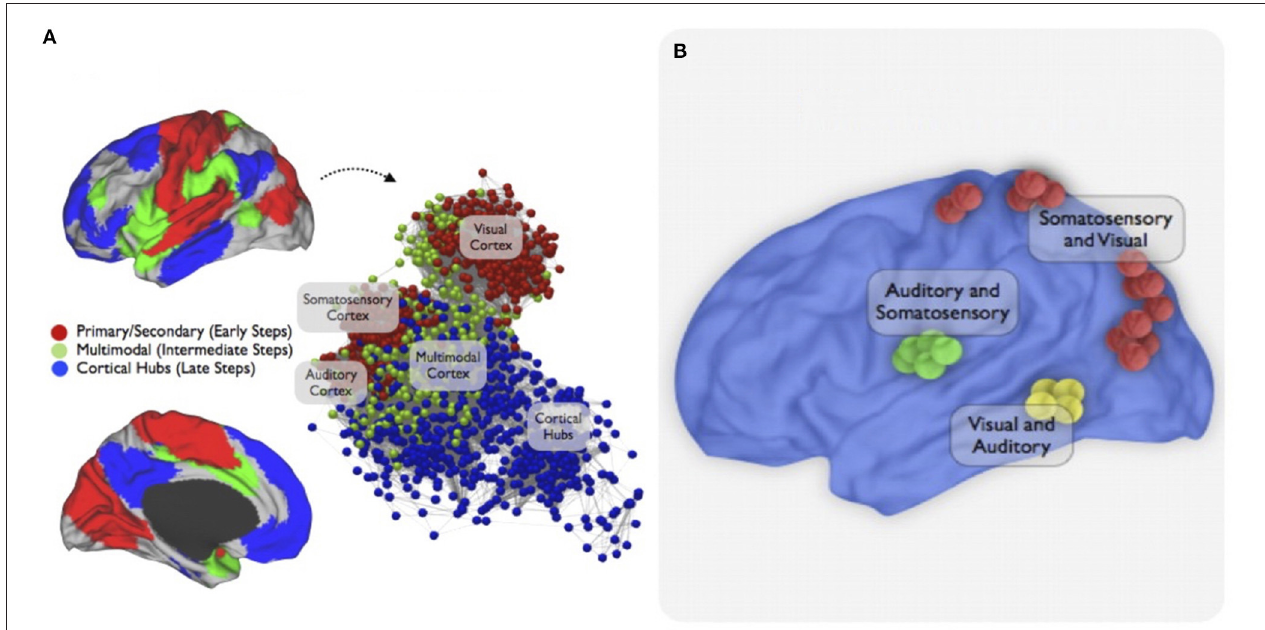
FIGURE 2 | Multimodal integration network. This figure is from a study that used resting-state functional connectivity MRI and stepwise functional connectivity (SFC) analysis to investigate sensory integration networks in the human brain. SFC patterns of primary cortices were first explored to target main convergence regions of multimodal integration. Then, a combined approach to highlight the topological convergence of the stepwise connectivity patterns in the three major sensory modalities was used. (A) The combined SFC map of connectivity patterns of brain regions of all modalities using a seed-based approach is shown. The sensory integration begins in the unimodal-related systems (early stages/red nodes) then converges in the multimodal integration network (intermediate stages / green nodes) before joining the cortical hubs (late stages / blue interface). An energy layout algorithm that considers the difference between geometric and pairwise shortest-path distances of nodes resulted in the network graph displays. (B) Finally, an interconnector network analysis explored specific functional connectivity profiles between pairs of sensory cortices showing bimodal integration regions between somatosensory, visual, and auditory cortices in the human brain. Figure from Sepulcre et al. (